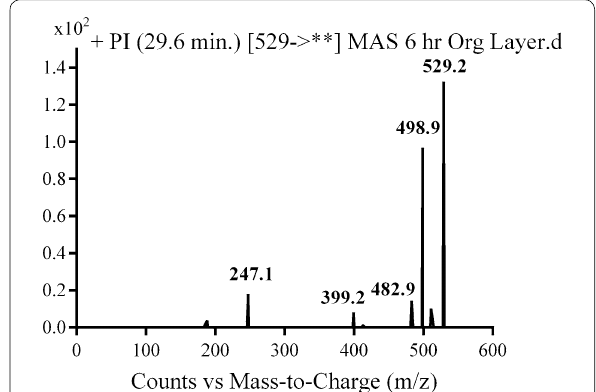
In the case of M9, parent ion at m/z 531 was frag- mented to ions at 513, 415, 381 and 123 (Fig. 11). Met- abolic pathways for M9 were supposed to be benzyl hydroxylation and hydroxylation of methyl piperazine ring (Scheme 8).